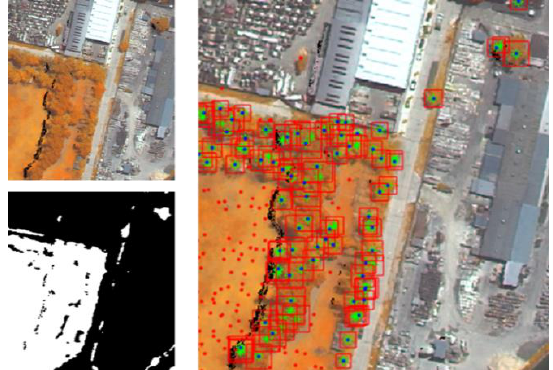
Figure 3: The illustration of the treetop detection. The details are in the text above.